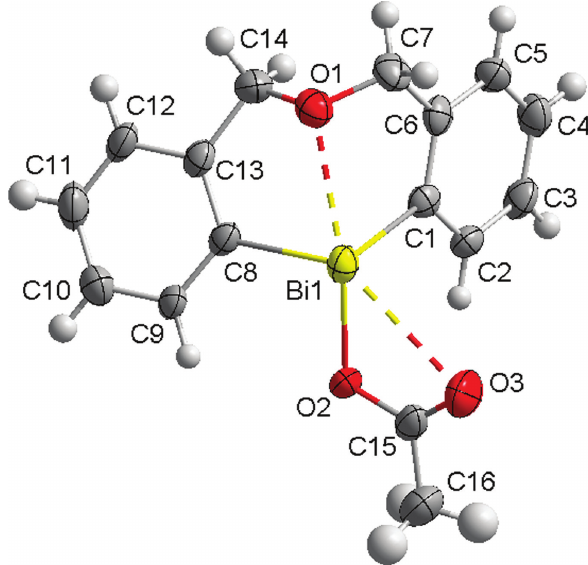
Table 1: Data collection and handling.